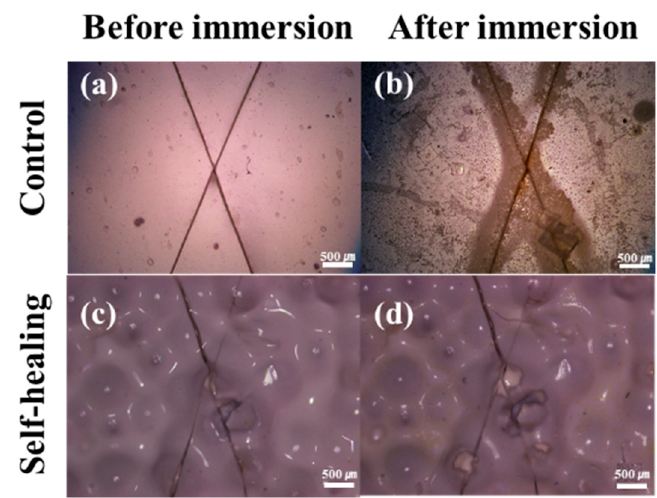
Figure 6. Optical microscope images of scratched control and self-healing coating samples before and after immersion for 48 h in a 25 wt % sodium chloride aqueous solution at − 20 °C. ( a ) Control coating before immersion; ( b ) control coating after immersion; ( c ) self-healing coating before immersion; ( d ) self-healing coating after immersion.